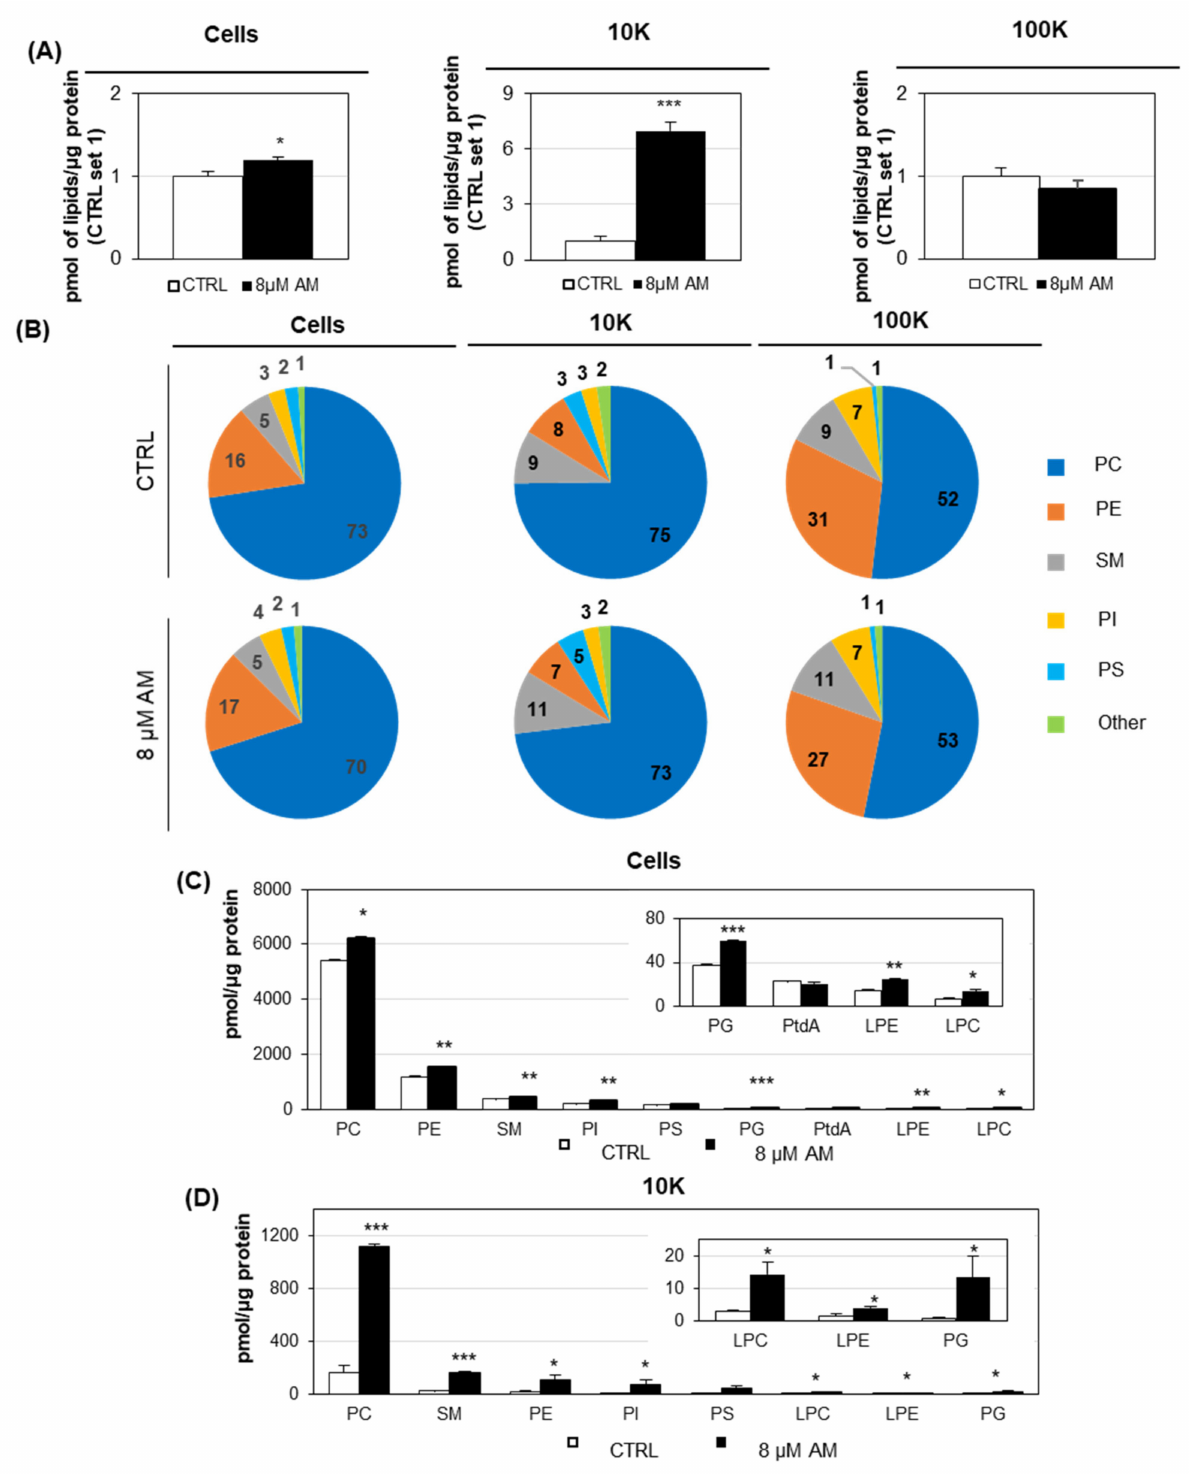
Figure 8. Phospholipid composition of AM-treated vs. control samples . Cells were incubated with 8 µ M AM for 24 h, and then 10K and 100K EVs were isolated from cell culture medium by dUC. Phospholipid content of AM-treated and control cells, and their released 10K and 100K EVs, were analyzed by LC/MS. ( A ) Relative amount of phospholipid normalized for protein content for cells ( left ), 10K EVs ( middle ), and 100K EVs ( right ). Data are reported as mean ± S.E. of three independent experiments, each in duplicate (* p < 0.05, ** p < 0.01, *** p < 0.001, AM-treated vs. vehicle-treated cells). ( B ) Phospholipid subclasses composition of AM-treated vs. control cells and their released EVs. The amount of each phospholipid subclass is expressed as the percentage of the sum of all identified lipids. The category indicated as